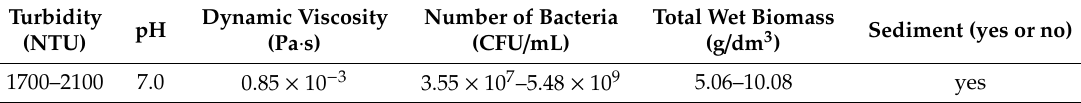
Table 3. Physicochemical characteristic of glycerol fermentation broths with Citrobacter freundii